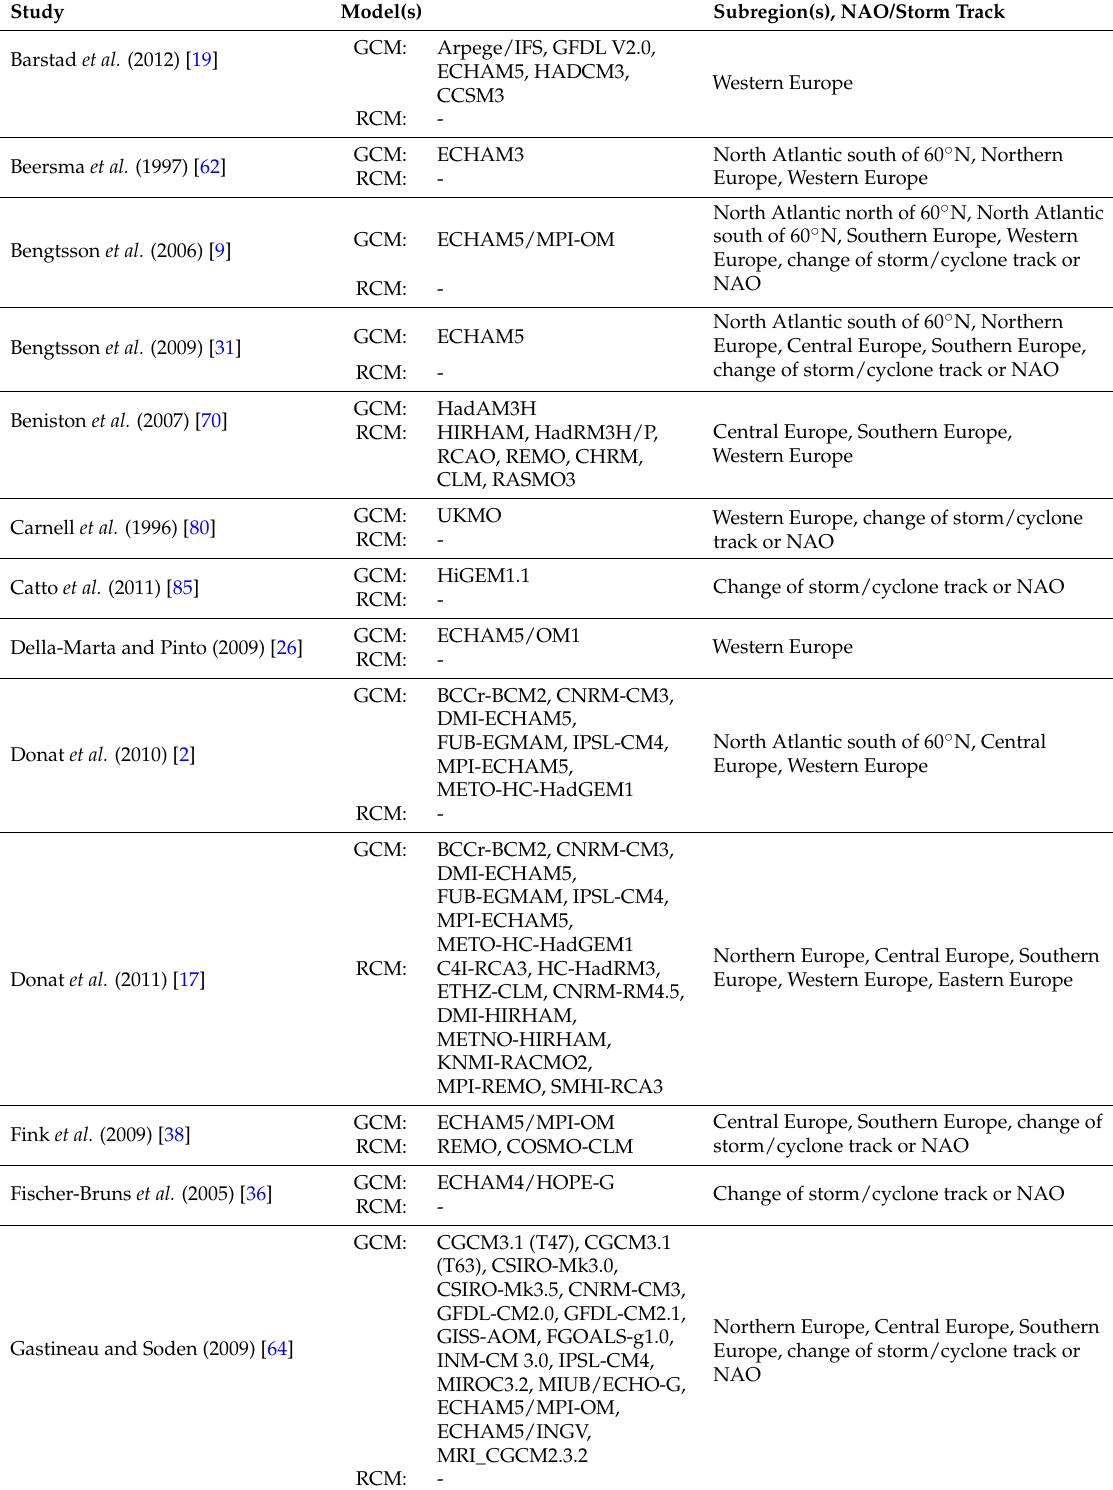
Table A1. Models used or mentioned in the reviewed studies and subregion(s) covered by the model grids. Although not all listed models are general circulation models, GCM is used to indicate the global scale of the model grid. RCM stands for regional climate model or indicates the regional scale of the model grid. The listed studies are sorted according to the surname of the lead